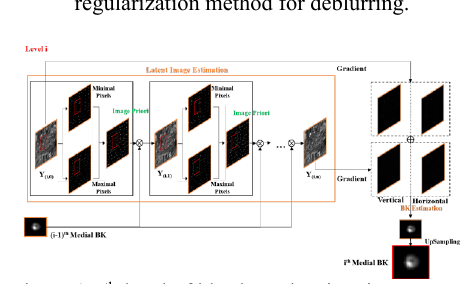
Figure 3. i th -level of blur kernel estimation process.